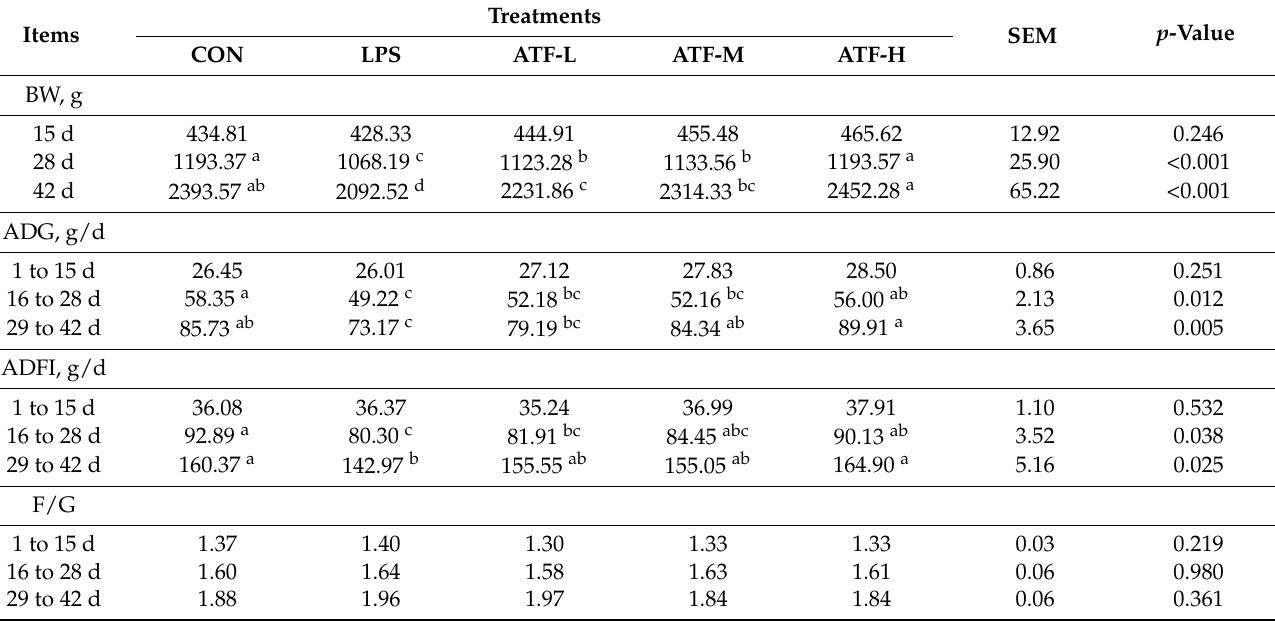
Table 3. Effect of ATF on the growth performance of broilers challenged with